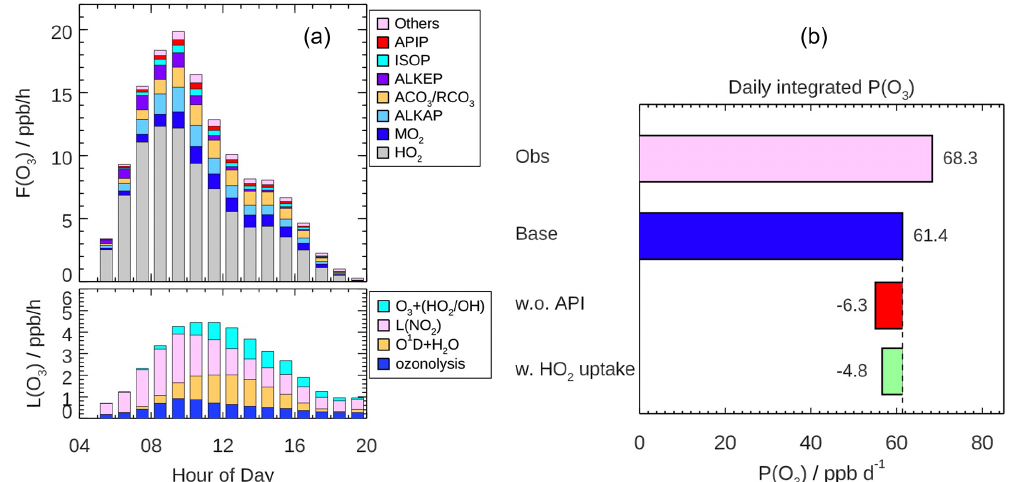
Figure 10. (a) Mean diurnal profiles of the speciation ozone formation rate ( F (O x )) from different peroxy radical species (upper panel) and the speciation ozone destruction rate ( L (O x ), lower panel) calculated based on the measured OH and HO 2 and modeled RO 2 radicals. (b) Daily (08:00–16:00) integrated net ozone production calculated from the observed and modeled radical concentration, respectively. The discrepancies between two model scenarios run (Scenario 1: without α -pinene constrained; Scenario 2: with HO 2 heterogeneous uptake considered by assuming γ to be 0.08) from the base case are also